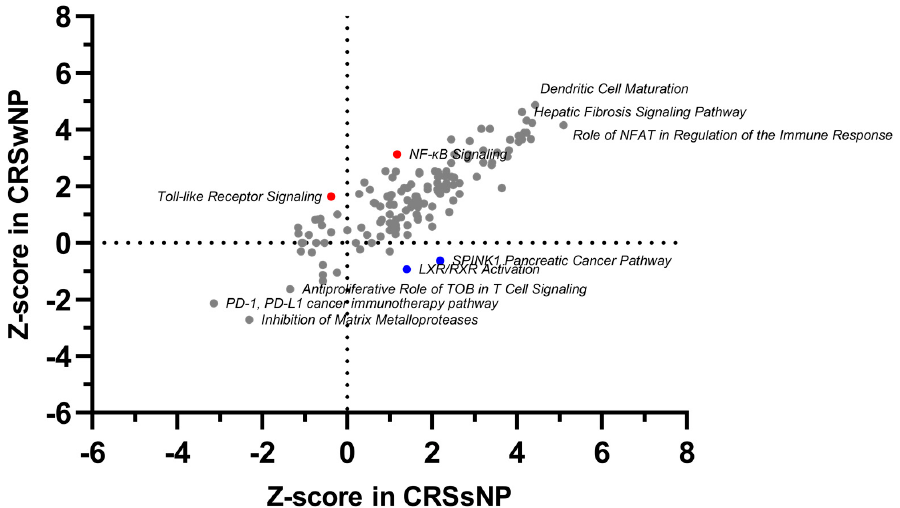
Figure 2. Comparison of enriched canonical pathways in CRSwNP and CRSsNP. The plot is based on the Z-score calculations obtained for a given set of genes using QIAGEN’s Ingenuity® Pathway Analysis (IPA®, QIAGEN, www.qiagen.com/ingenuity (accessed on 20 November 2021)). A positive Z-score represents strongly activated (Z-score > 2) pathways, and a negative Z-score represents significantly inhibited (Z-score < − 2) pathways. Proposed unique phenotype-associated pathways are presented in red ( • ) for CRSwNP and in blue ( • ) for CRSsNP. Details in Supplementary Table S2 (Canonical pathways).